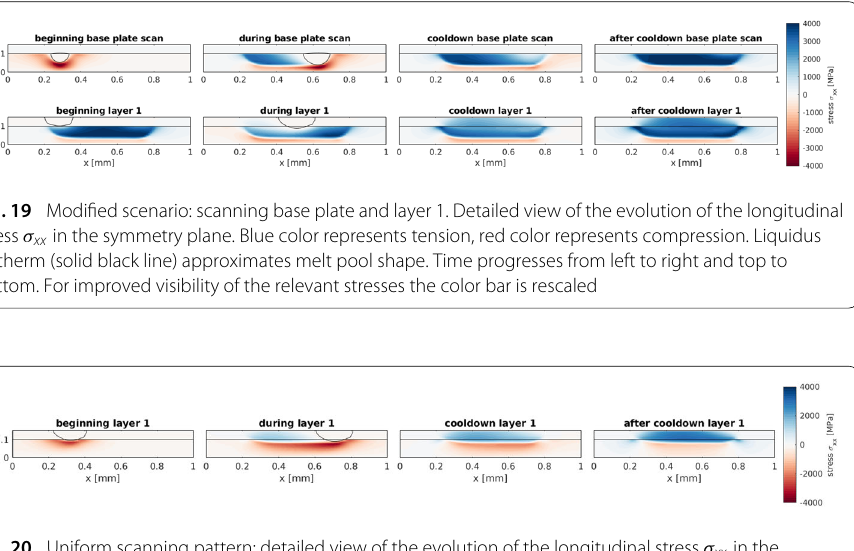
Fig. 20 Uniform scanning pattern: detailed view of the evolution of the longitudinal stress σ xx in the symmetry plane during scanning of layer 1. Blue color represents tension, red color represents compression. Liquidus isotherm (solid black line) approximates melt pool shape. Time progresses from left to right. For improved visibility of the relevant stresses the color bar is rescaled